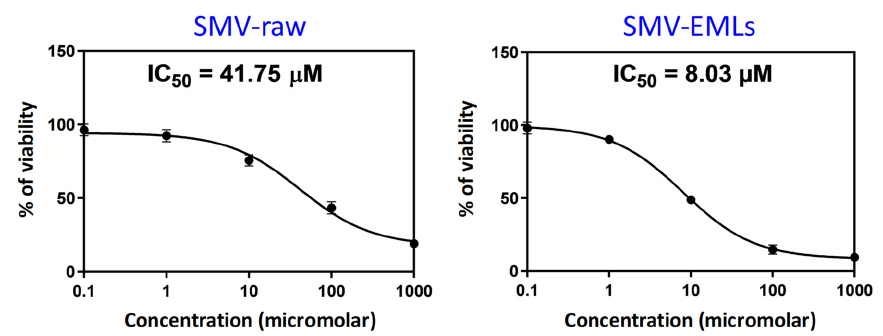
Figure 6. IC50 of the SMV-raw and SMV-EMLs in the MCF-7 cells. Data are the mean of 3 independent